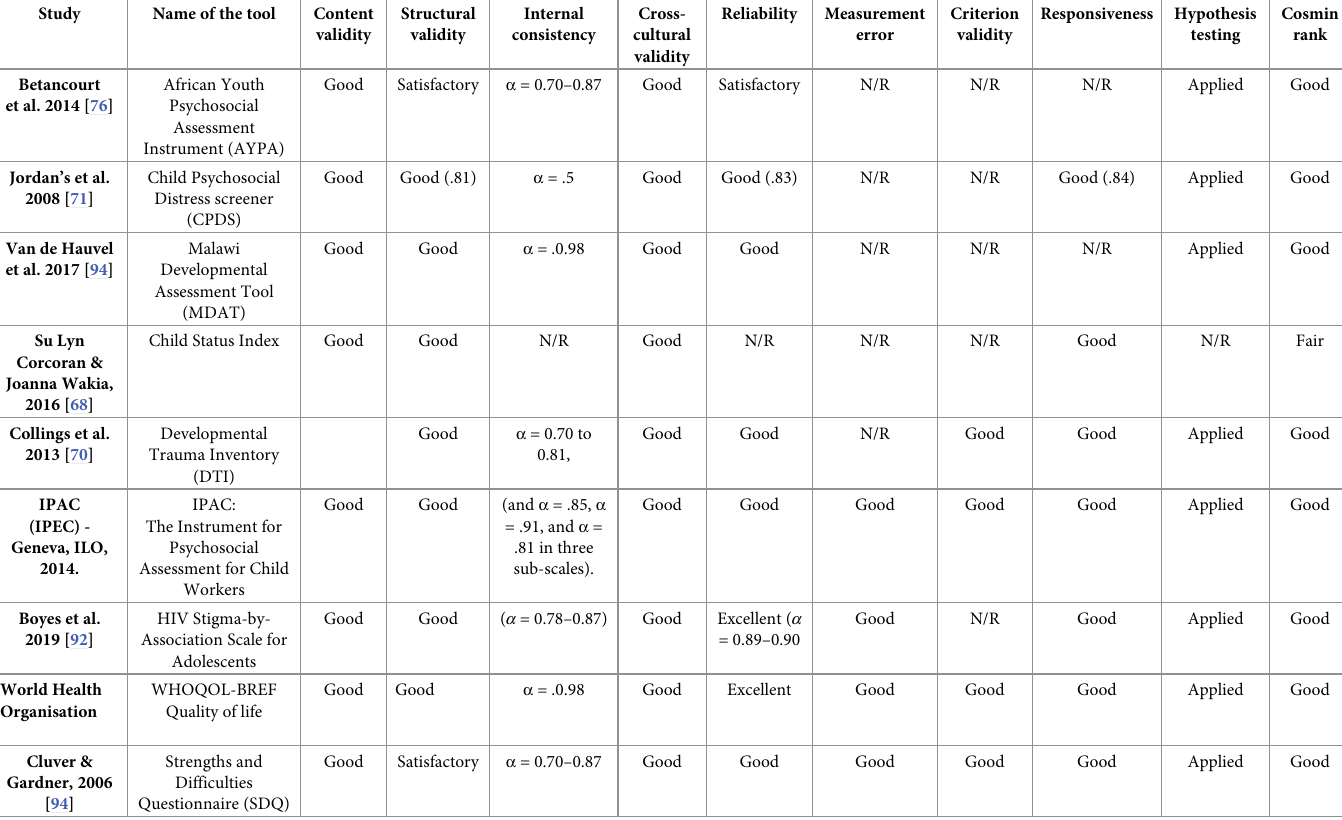
Table 6. COSMIN Checklist summary of the identified risk assessment